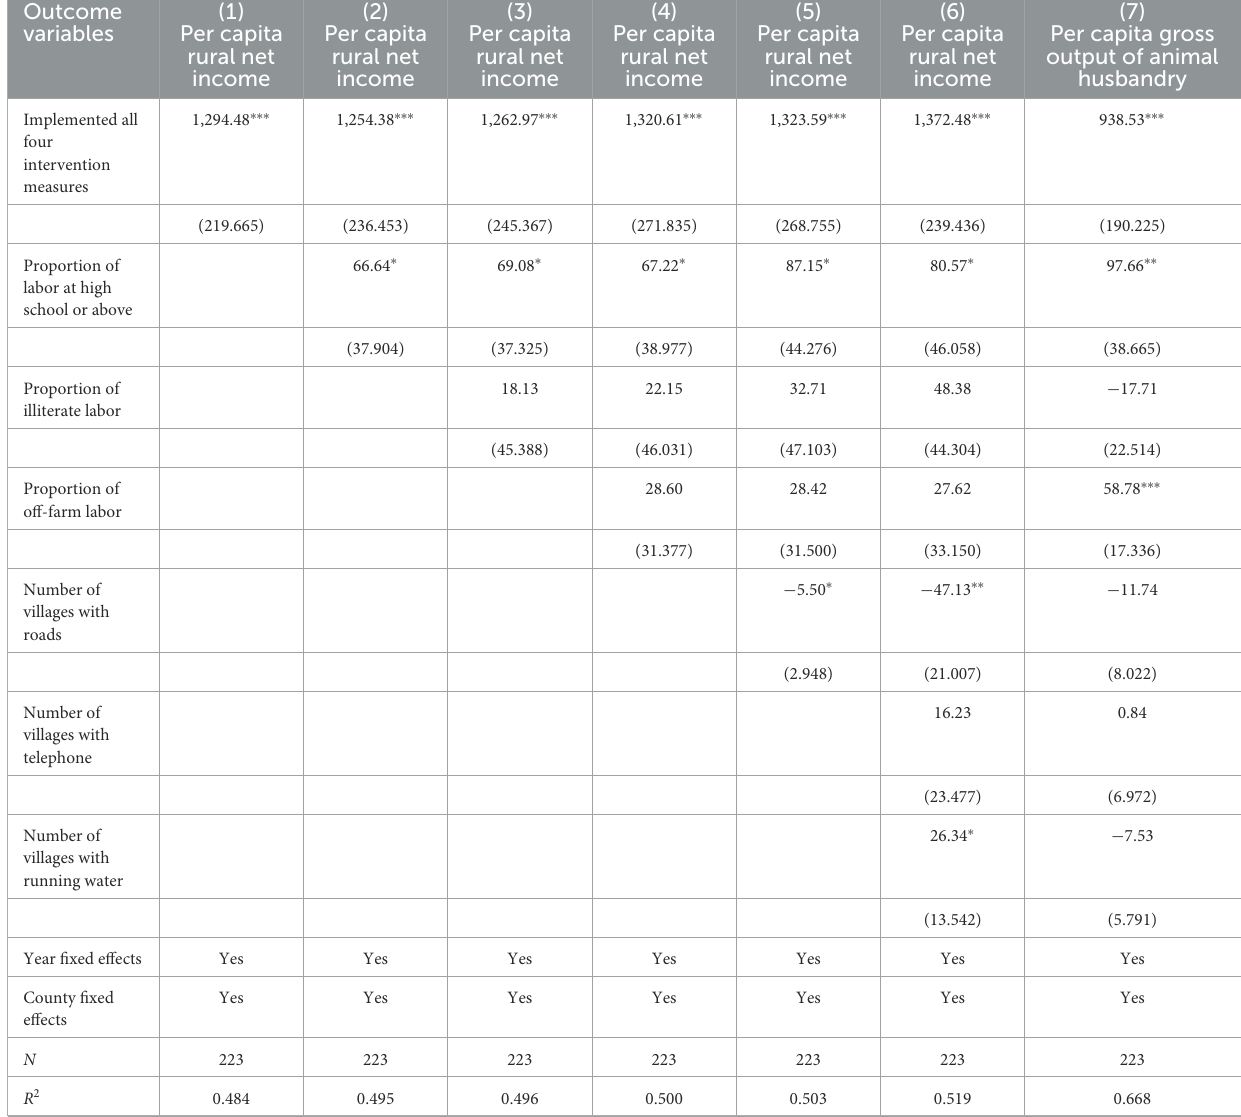
TABLE 6 Regression results of dynamic difference-in-differences